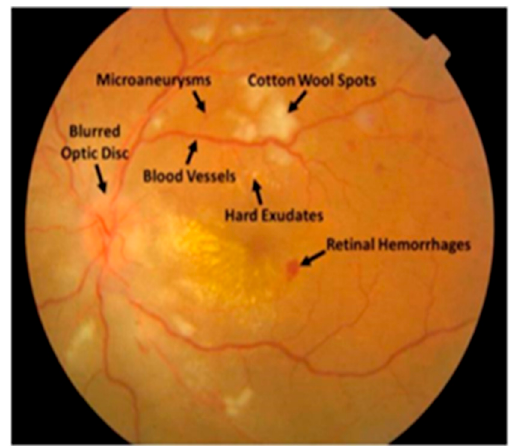
Figure 3. Representation of a fundus image with the lesion annotations.